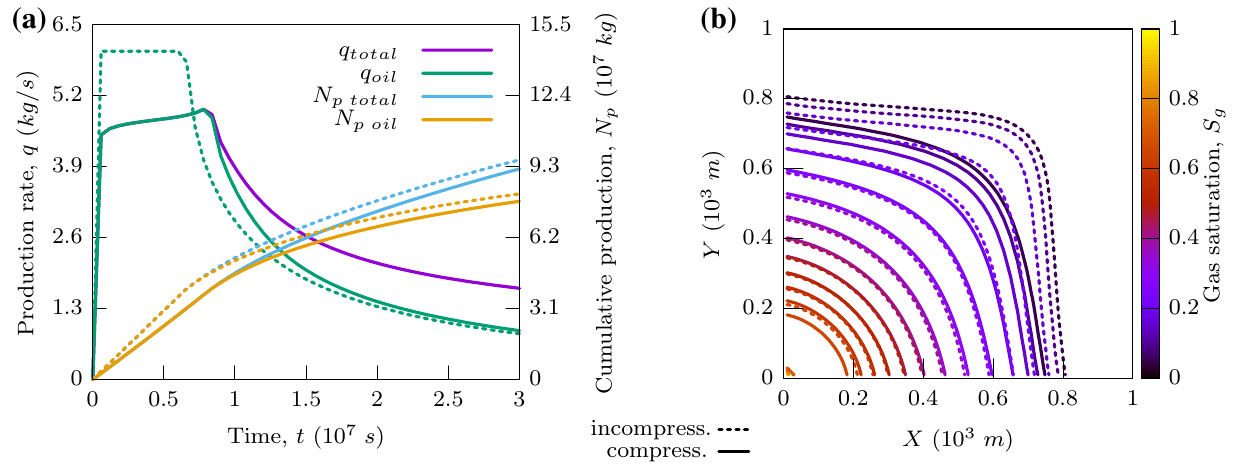
Fig. 8 Injectant gas CH 4 . 2D model. Scenario 4. Comparison of compressible and incompressible cases. a Production profiles. b Saturation pro- 5 × 10 6 file for